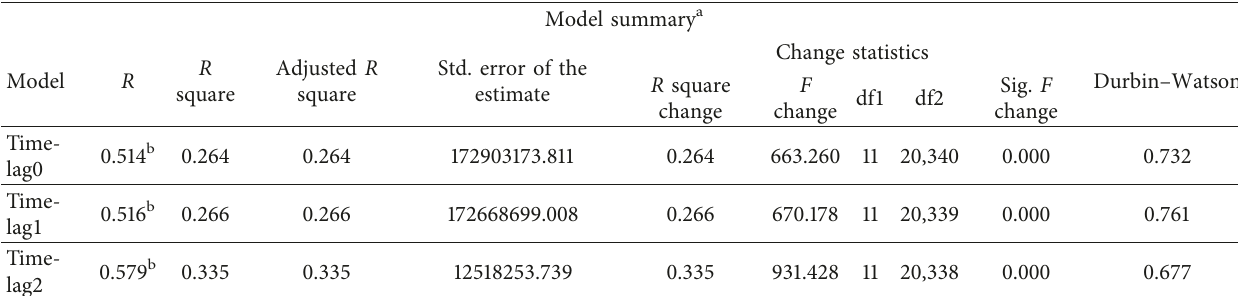
Table 18: Model summary for a DOE large office building depending on